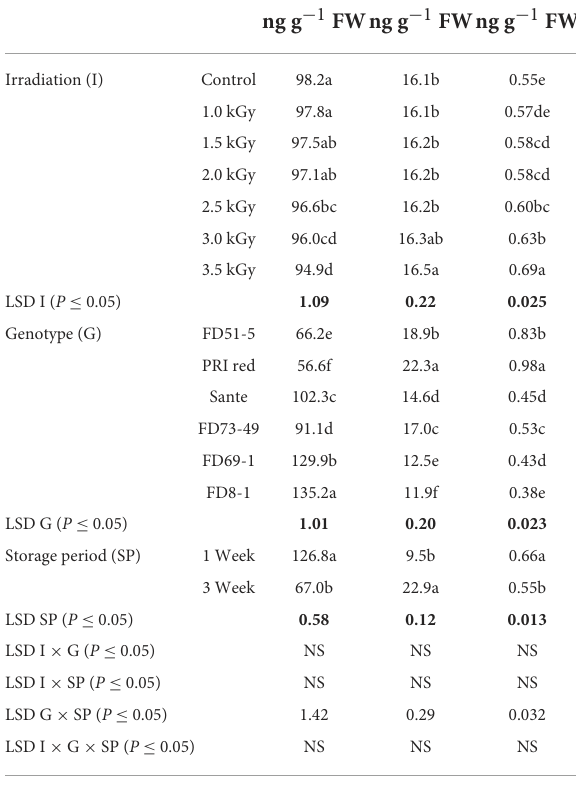
TABLE 5B Periodic changes in the contents of ABA, ZT, and GA 1 in experimental tubers of six potato genotypes following γ -radiation during